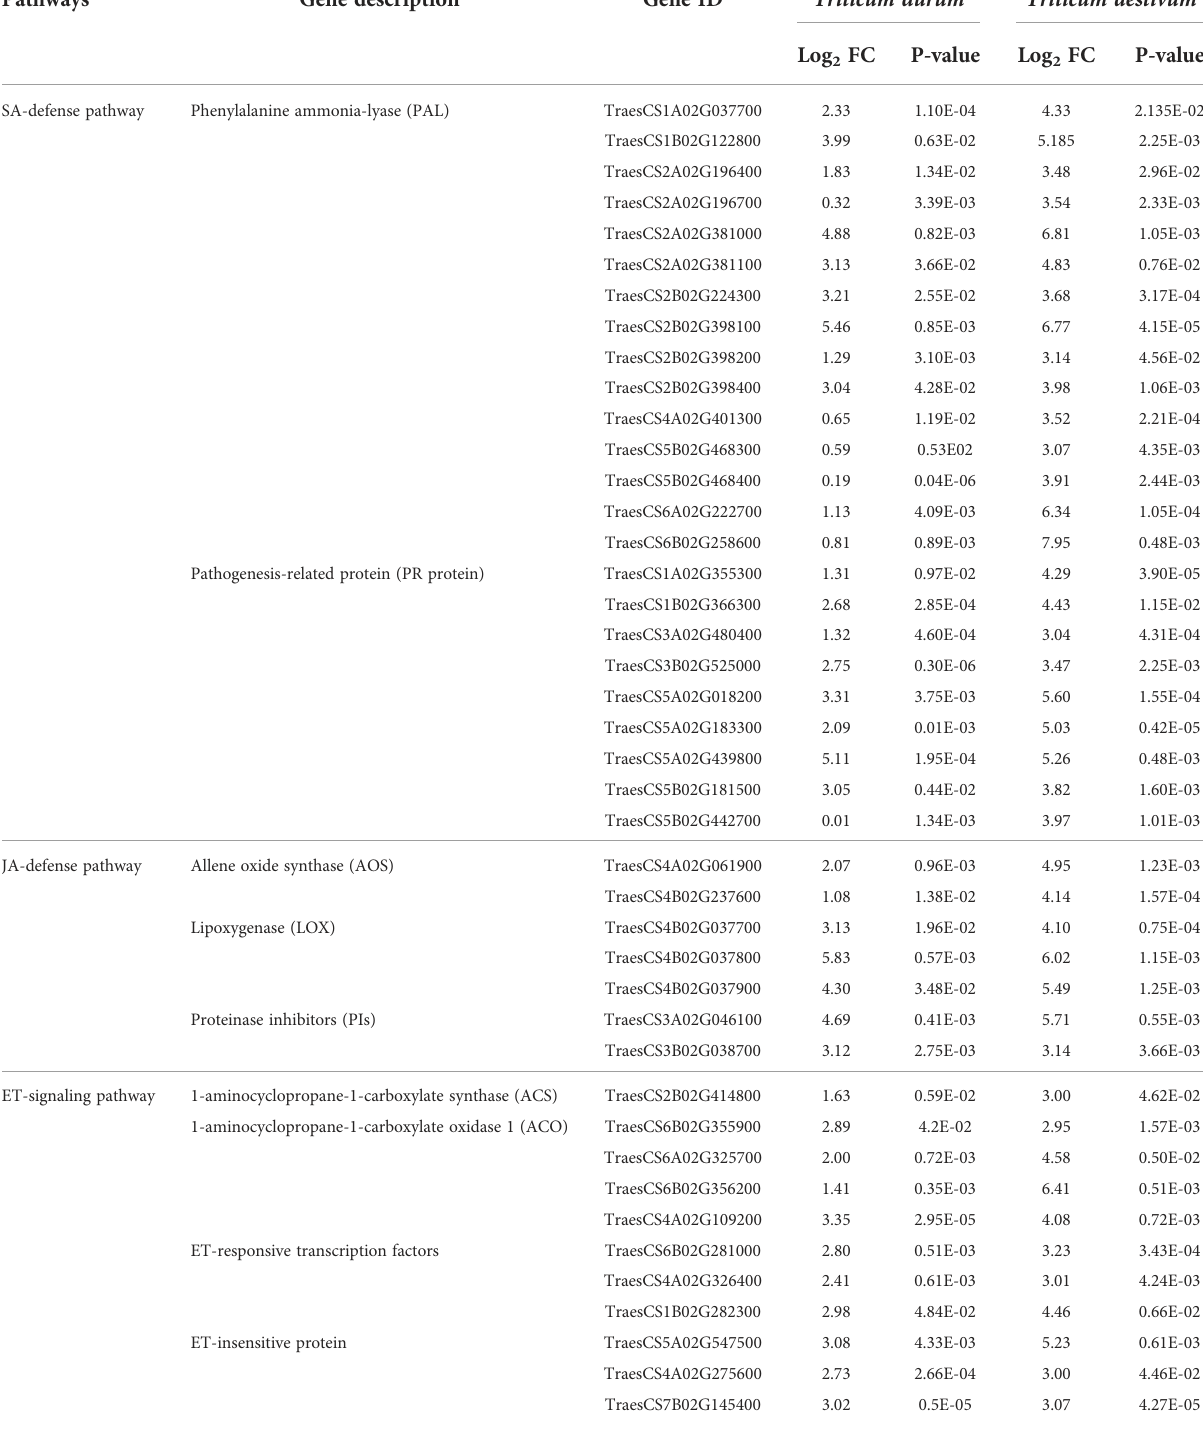
TABLE 5 Differentially expressed genes (DEGs) involved in salicylic acid (SA), jasmonic acid (JA), and ethylene (ET) dependent defense pathways.